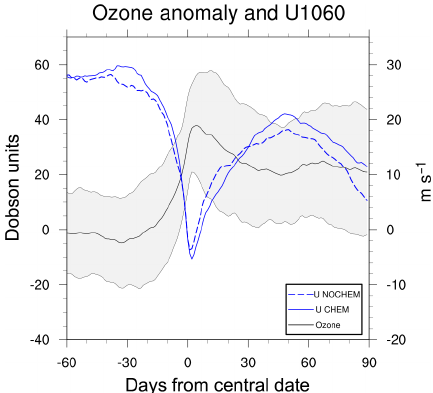
Figure 9. As in Fig. 7 but for March